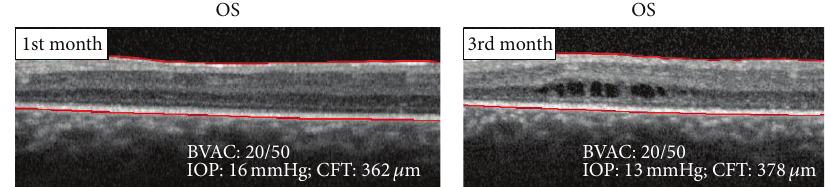
Figure 9: OCT spectral domain OS after subtenon depot triamcinolone.